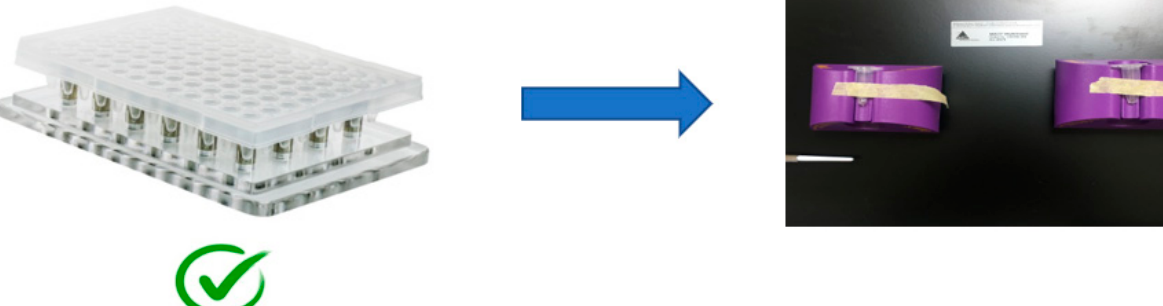
Figure 1. “Improvised device” used for ribosomal RNA depletion, RNA purification, and cDNA cleanup. The recommended plate magnetic separator is shown on the left.